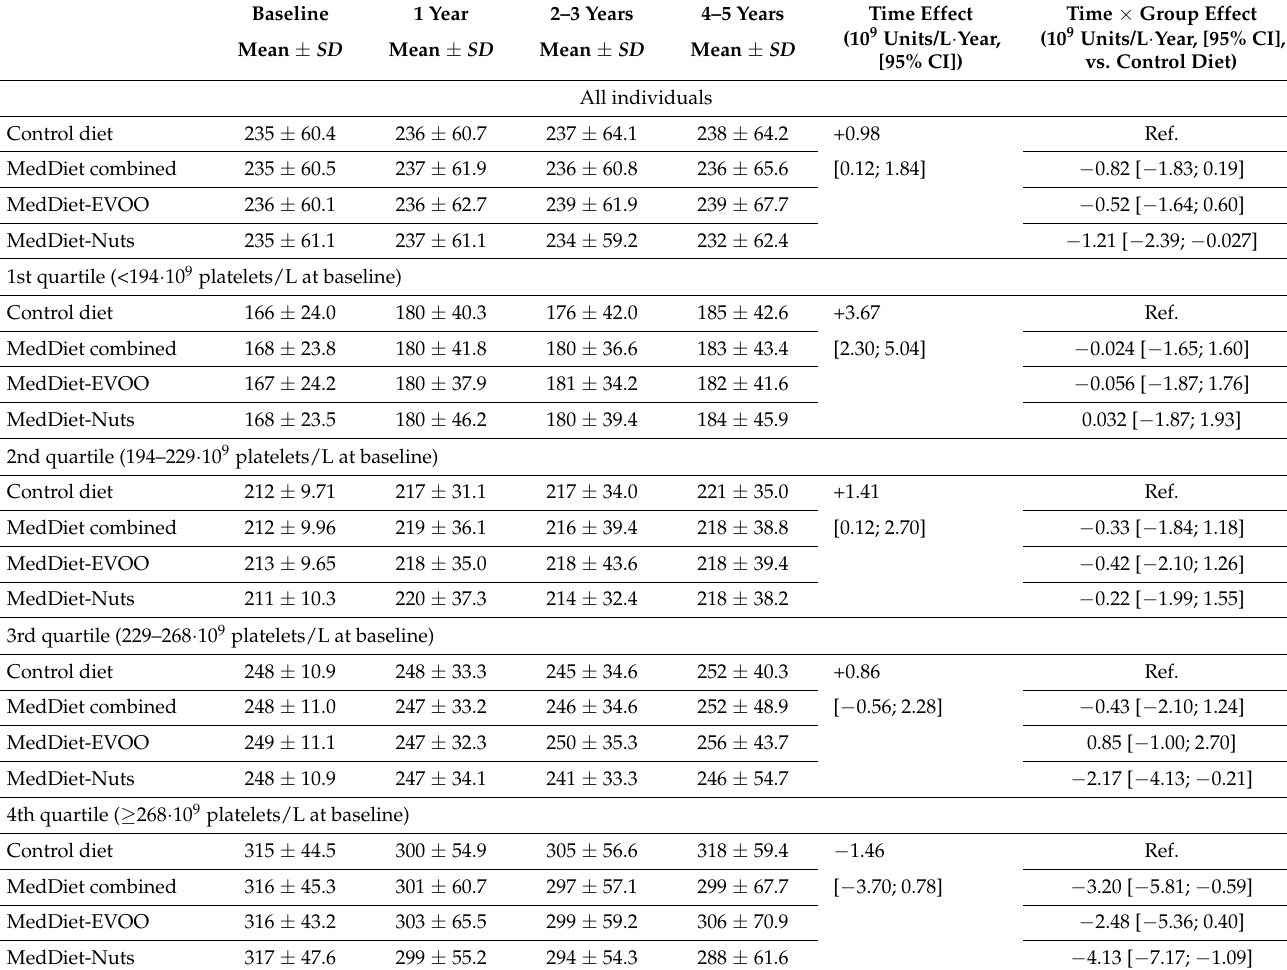
Table 2. Time-dependent changes in platelet count in the PREDIMED study groups 1